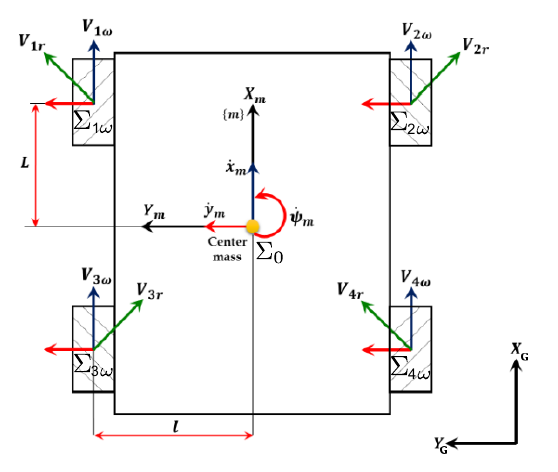
Figure 8. Disposition of the mecanum wheels and the